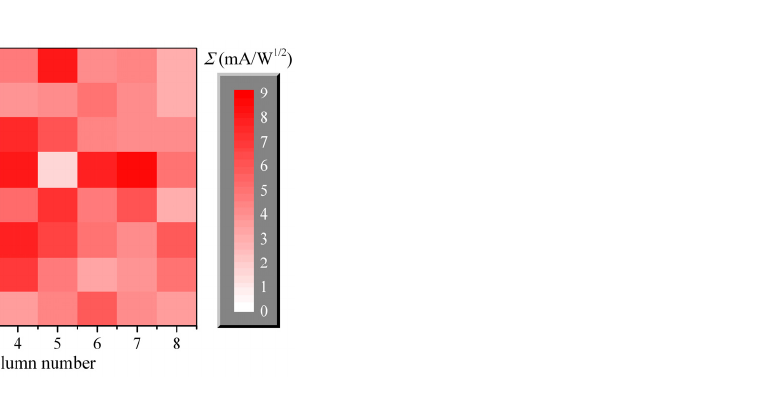
Figure 12. A map of the mixing elements sensitivity ( Σ ). The spatial arrangement of the map pixels corresponds to the spatial arrangement of the array pixels if we look at the receiver from the back side.